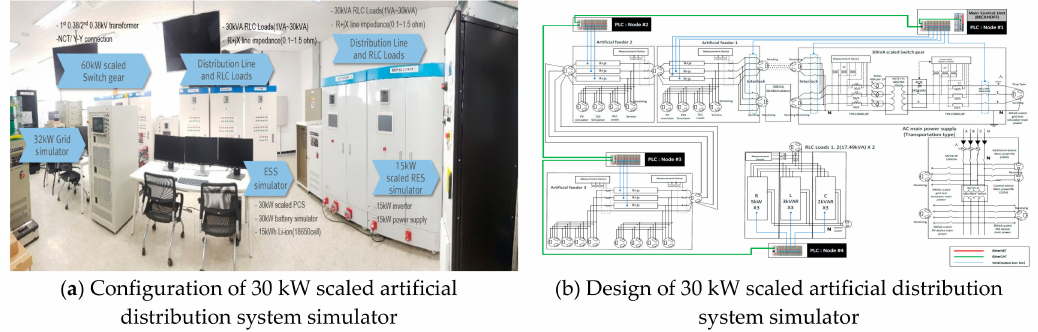
Figure 21. Configuration of 30 kW scaled artificial distribution system simulator.